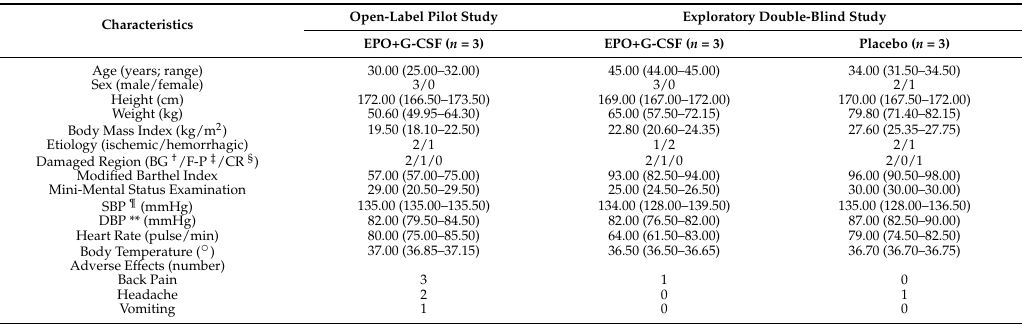
Table 1. Clinical characteristics of patients at time of enrollment in the study.